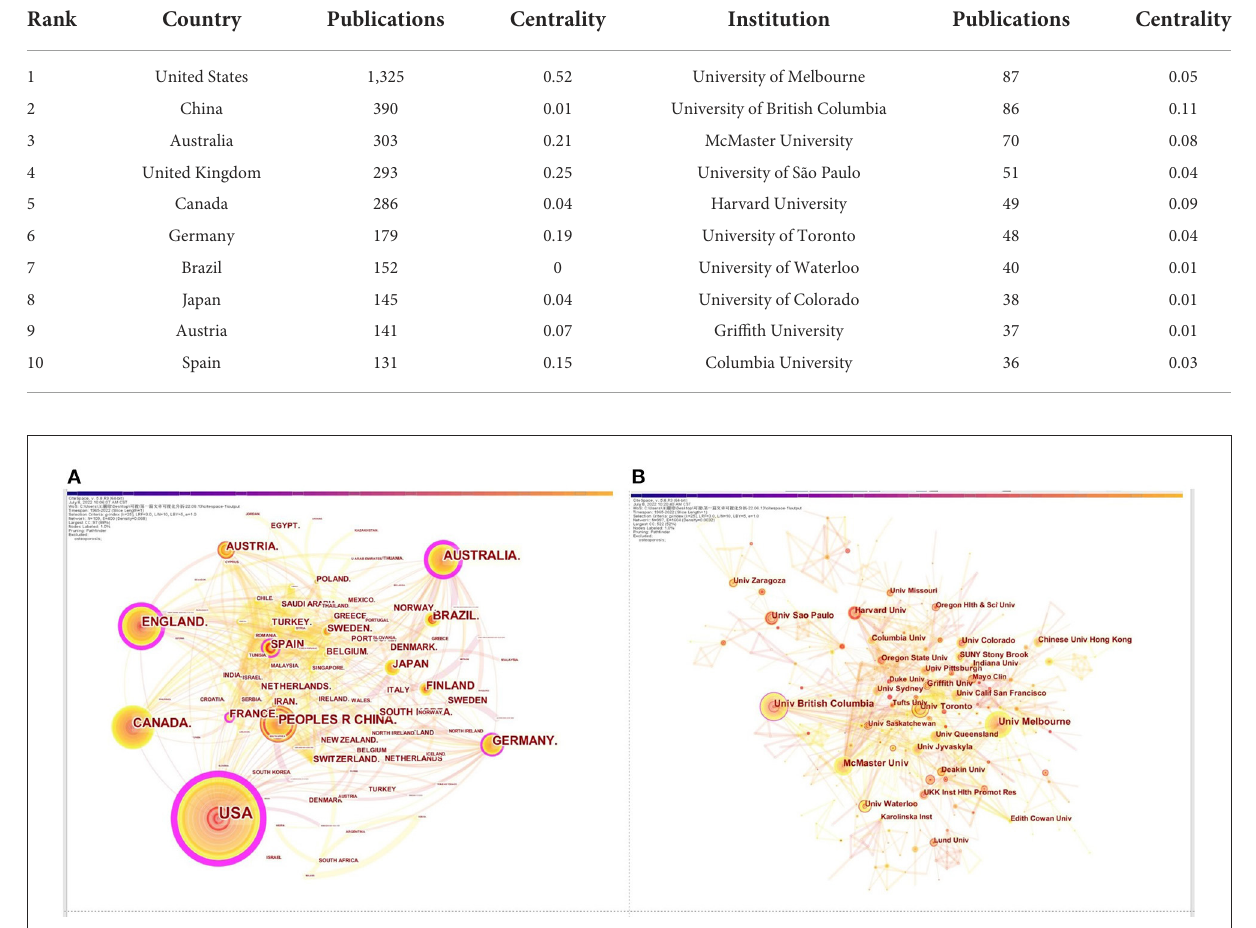
FIGURE2 Cooperation network diagram of countries (A) ; Cooperation network diagram of institutions (B) .